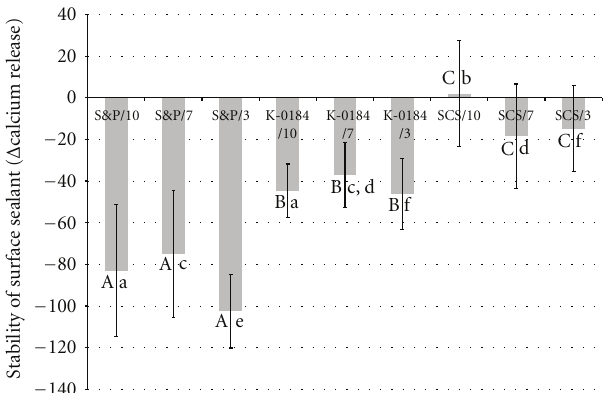
Figure 2: Stability (mean Δ calcium release ( µ g) ± SD) ( v = 500 µ L) of the respective surface sealants cured with di ff erent light exposure times. (S&P = Seal&Protect, K-0184 = experimental sealer and SCS = Syntac Classis system; 10 = 10 s light-curing time, 7 = 7s light-curing time, etc.) Lower values indicate lower stability of the surface sealants. Within the same material, values for di ff erent light-curing durations, which are not statistically significantly di ff erent, are marked with identical uppercase letters. Comparisons between values within the same light-curing duration that are not significantly di ff erent are marked with same lower case